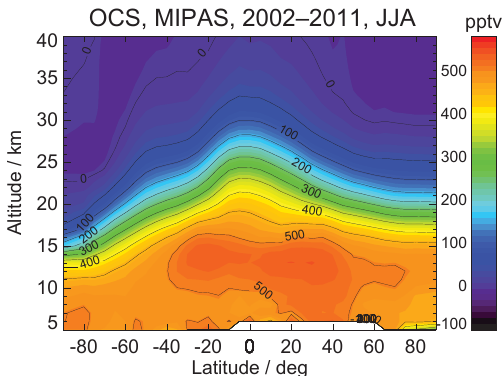
Figure 14. Latitudinal distribution of OCS, observed by MIPAS. Extracted from Glatthor et al.